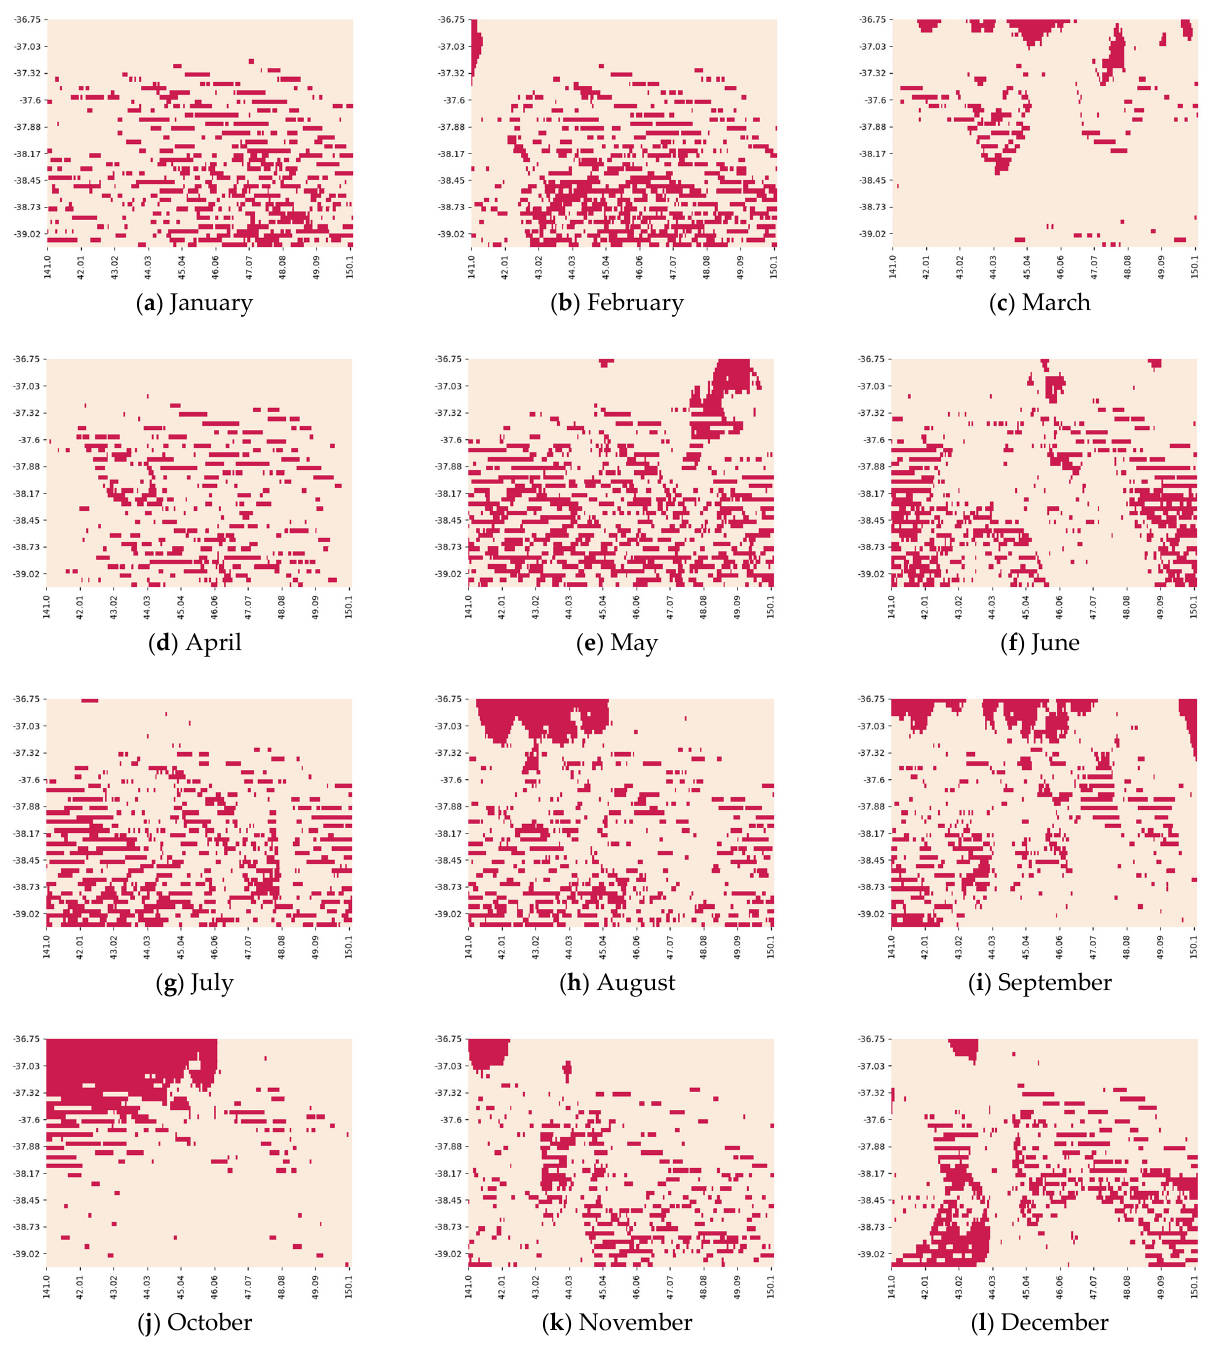
Figure 4. Heatmaps of the geolocated grids for Temperate Region of Australia in 2015 for 12 months. Cream colour denotes the grids which are not classified correctly. Red colour indicates the grids which are classified correctly. Figures ( a – l ) represent the heat map for 12 different months,